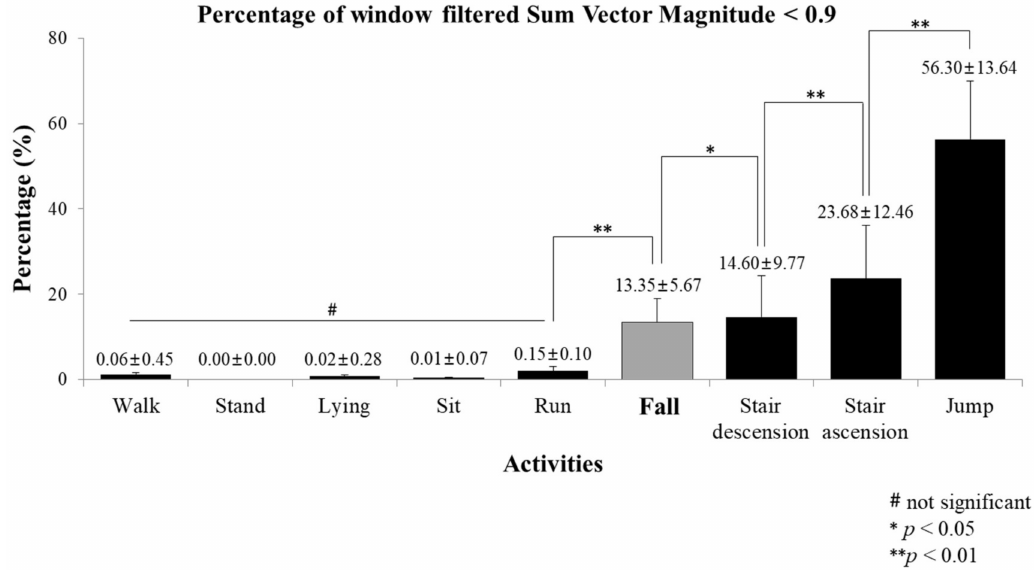
Figure 3. The average percentage of each window where filtered Sum Vector Magnitude is below the 0.9 threshold. This average is computed across all 20 subjects, and all trials, for every ADL and fall.